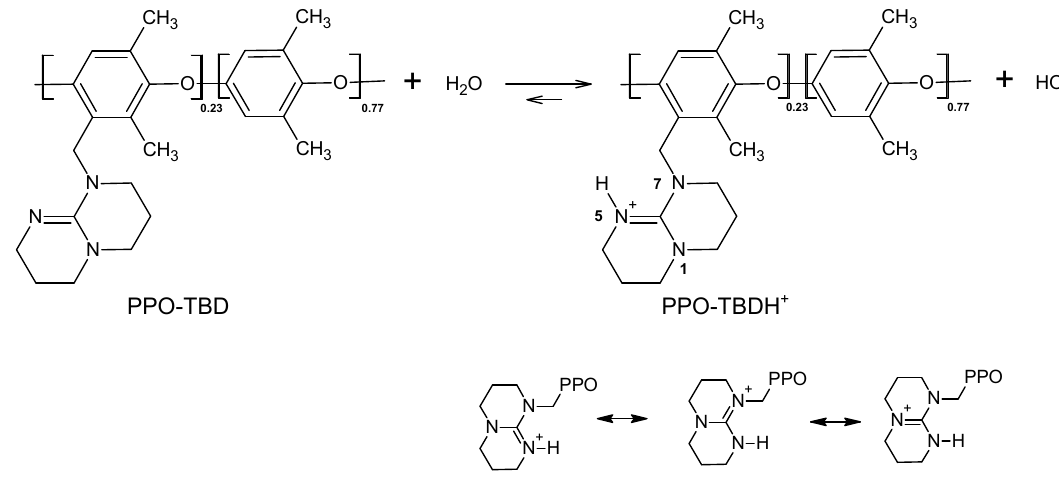
Figure 4. Dissociation acid-base equilibrium of PPO-TBD.